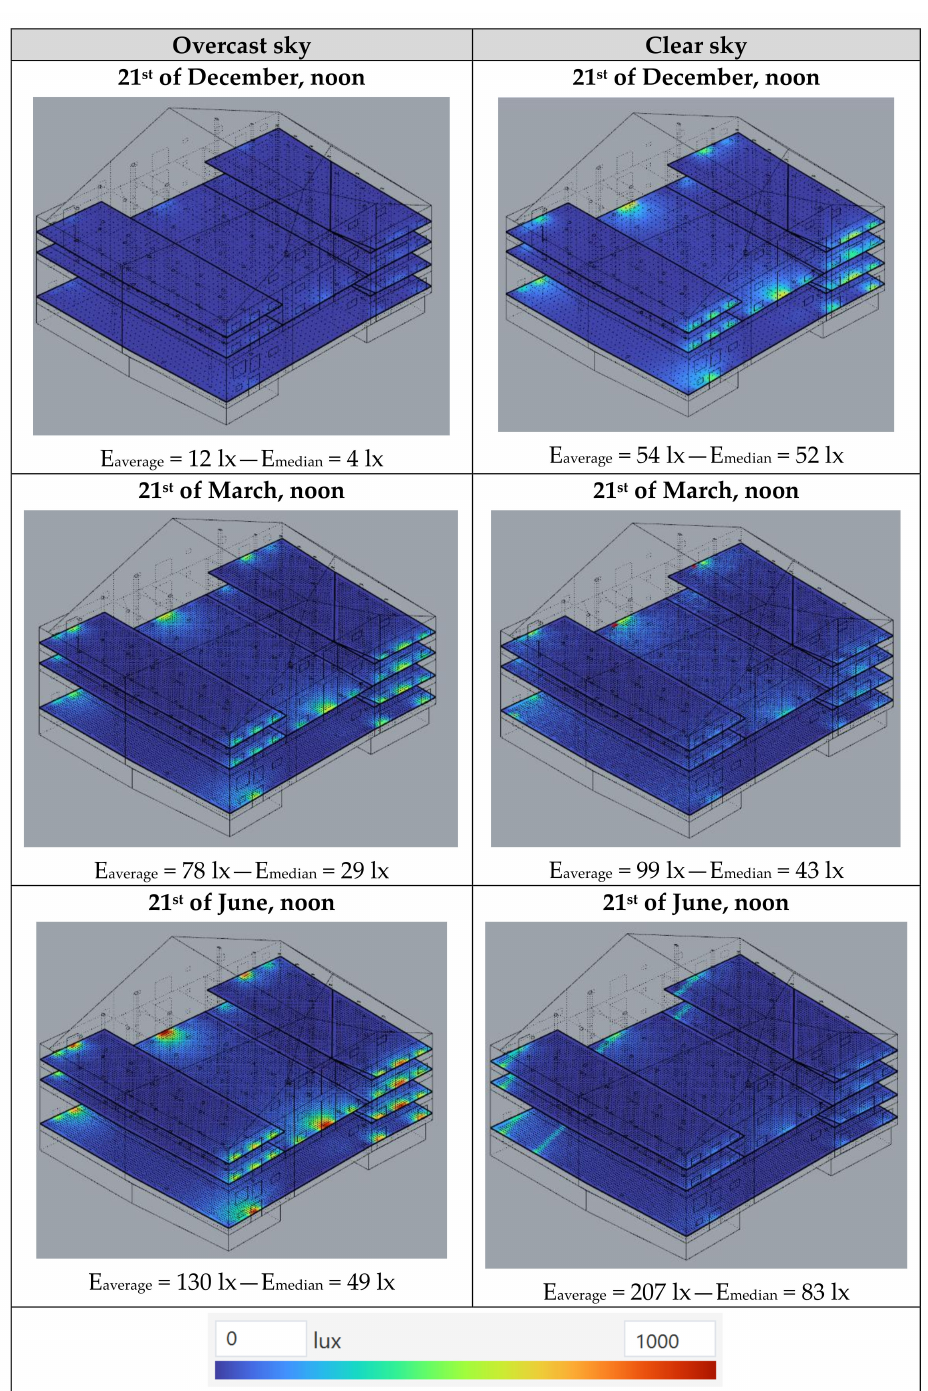
Figure 13. Point-in-time illuminances inside the building for the existing building